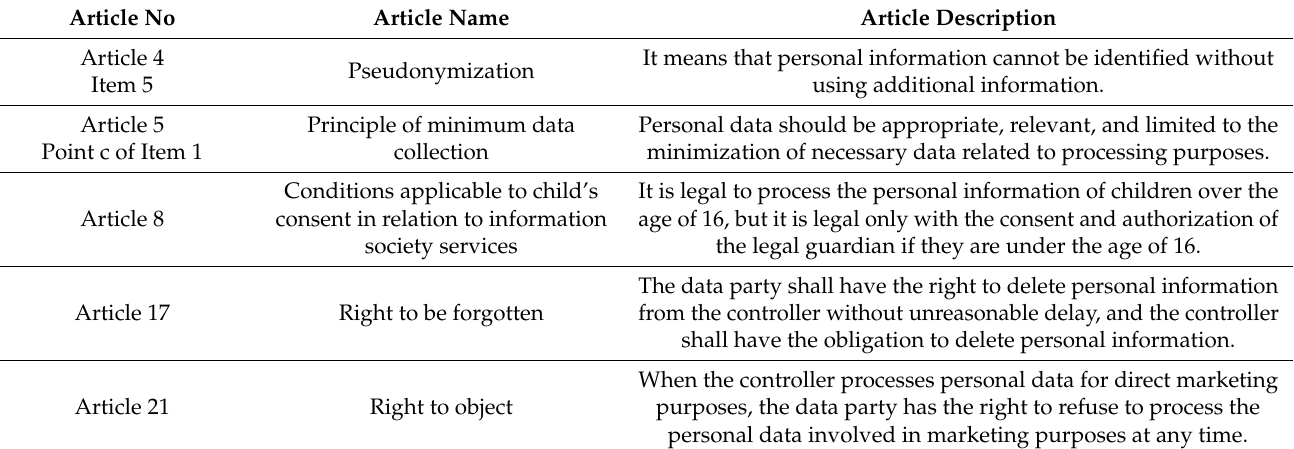
Table 2. Explanation of GDPR Articles